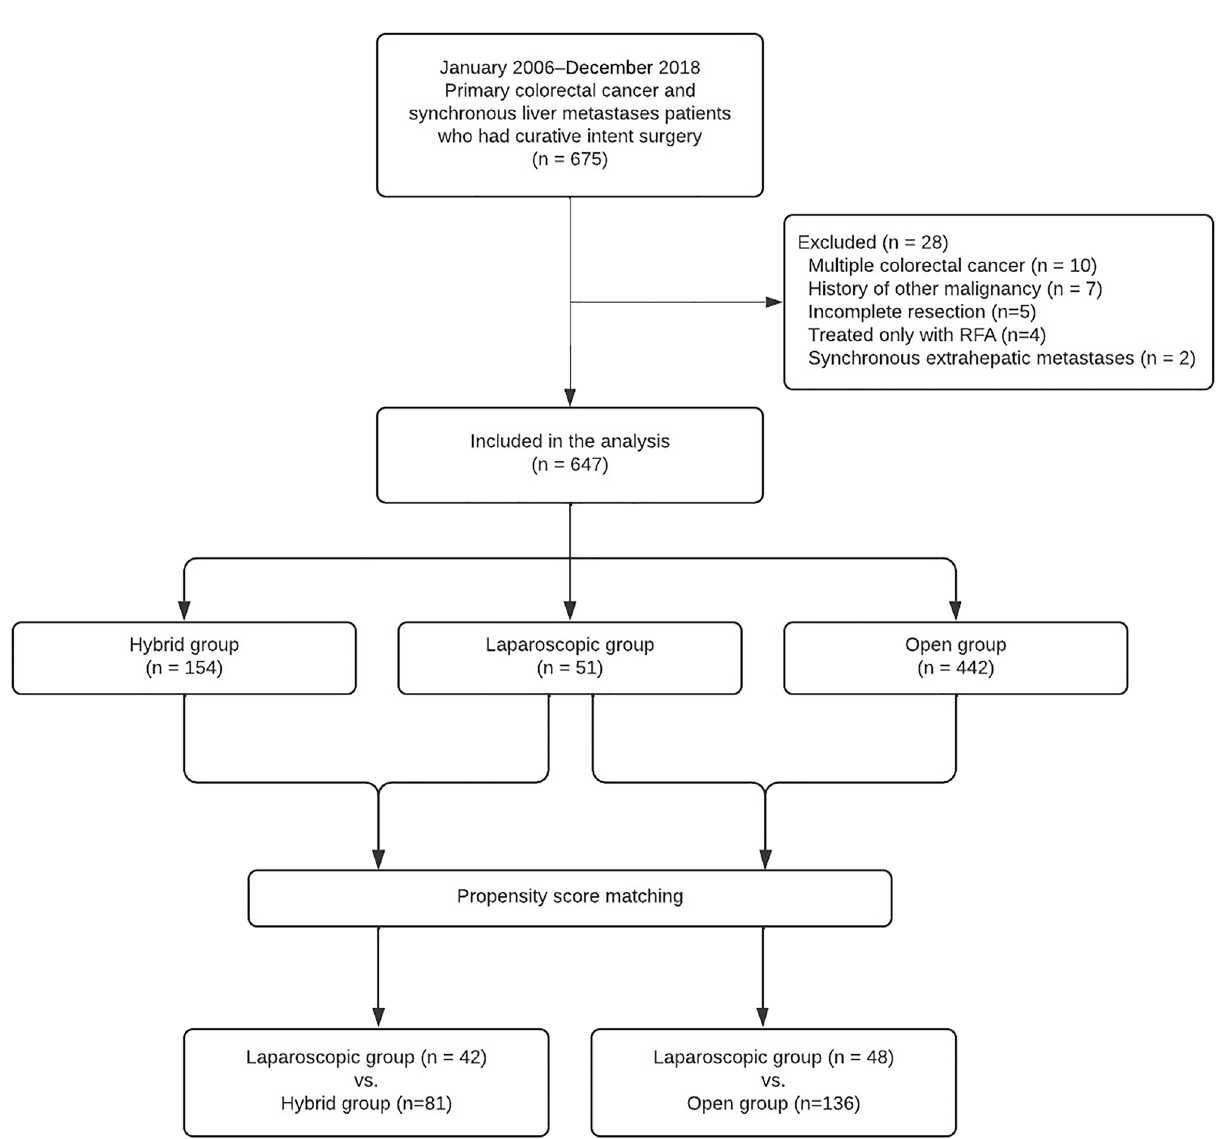
Table 1. Patients and disease characteristics according to treatment group. Lap, laparoscopic; BMI, body mass index; ASA-PS, American Society of Anesthesiologists physical status classification, Rt. colon, right colon; Lt. colon, left colon; Tx, therapy; CTx, chemotherapy; CRTx, chemoradiotherapy; CEA, carcinoembryonic antigen; N.A., not applicable. *Segments 1, 4a, 7, and/or 8. † The hilum, major hepatic veins, and/or inferior vena cava.